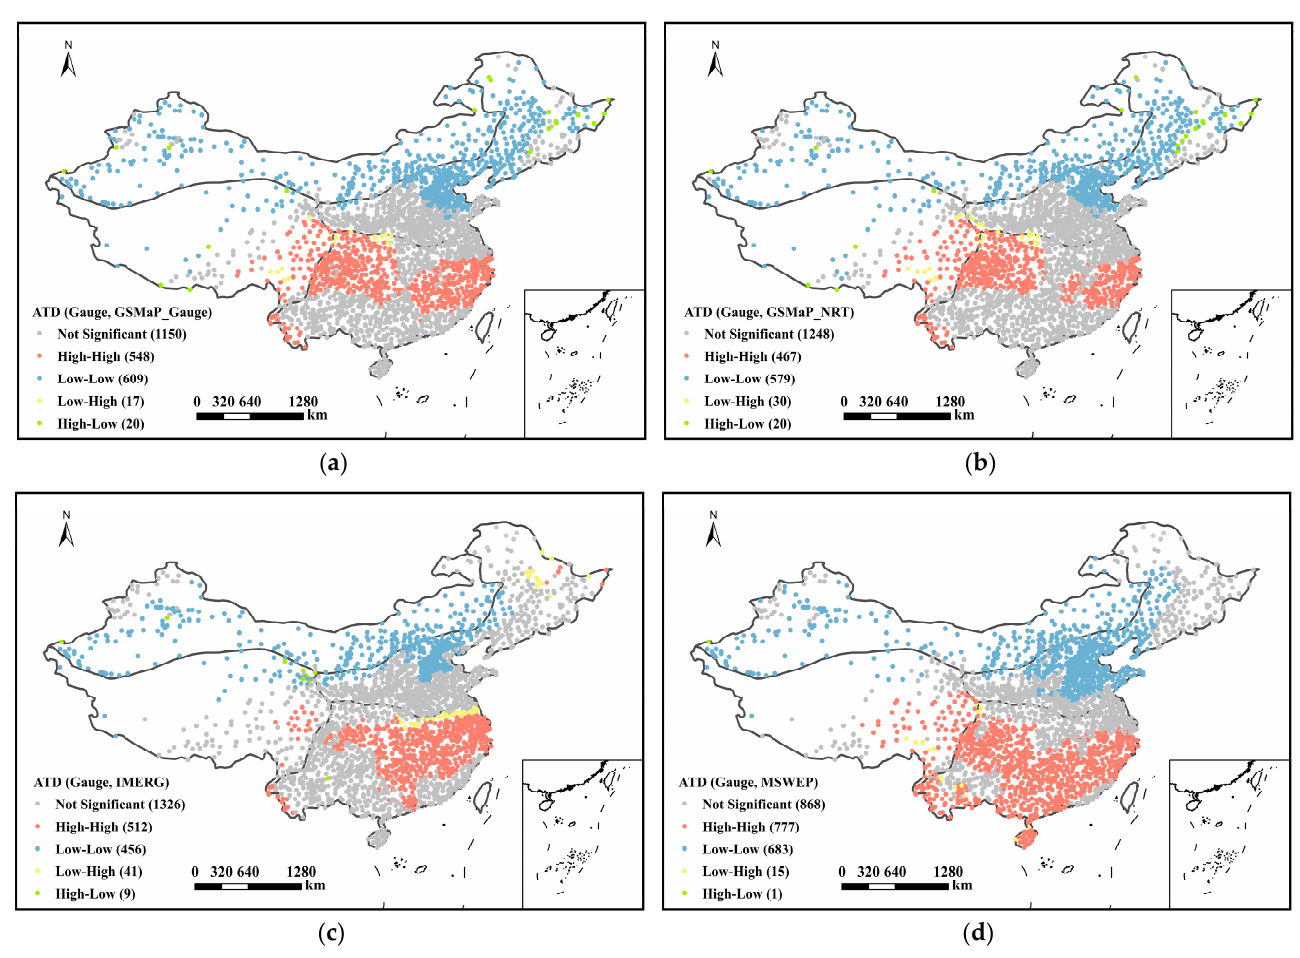
Figure 4. The LISA cluster maps of ATP between the gauge observations and the four SPPs and the number in the bracket represent the corresponding number of gauges: ( a ) GSMaP_Gauge, ( b ) GSMaP_NRT, ( c ) IMERG, and ( d ) MSWEP.